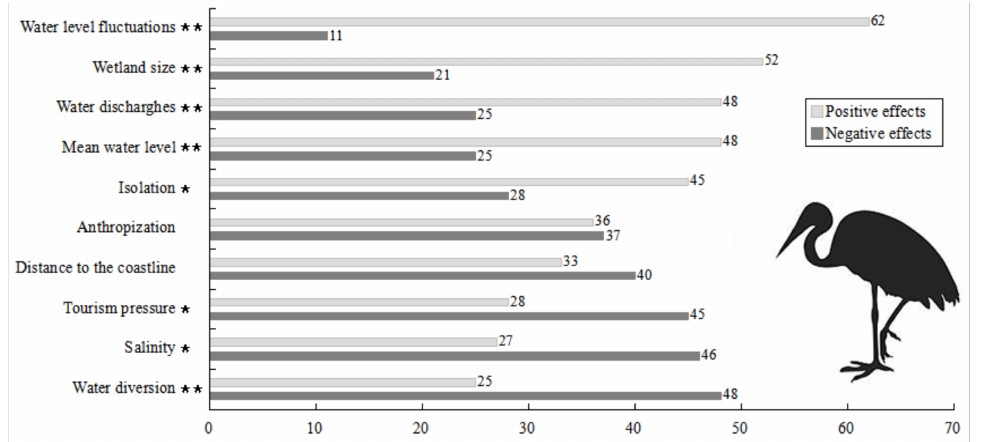
Figure 5. The number of bird species favored or disfavored by each wetland attribute is shown. Asterisks indicate the statistical significance (* p < 0.05, ** p < 0.01) of each attribute’s effect on the avian diversity (73 species) of the Sicilian wetlands based on the cumulative binomial